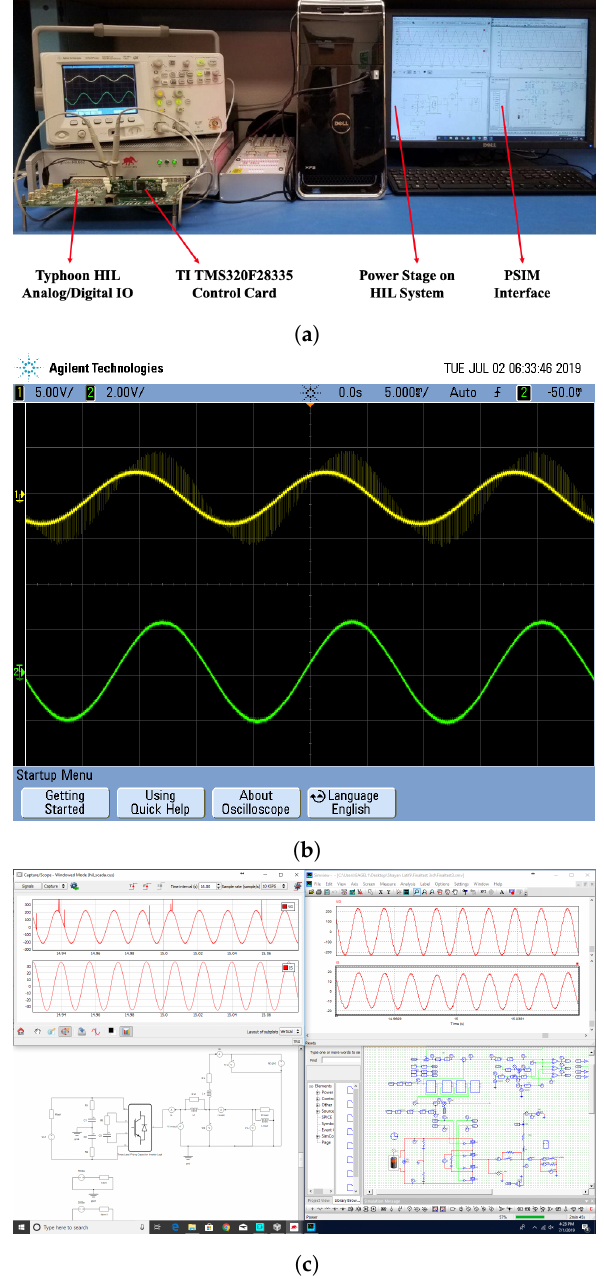
Figure 11. Experimental setup: ( a ) setup overview; ( b ) oscilloscope showing the voltage (top) and current (bottom) of the AC grid in reactive power compensation mode; ( c ) PSIM interface and implemented power stage on Typhoon HIL